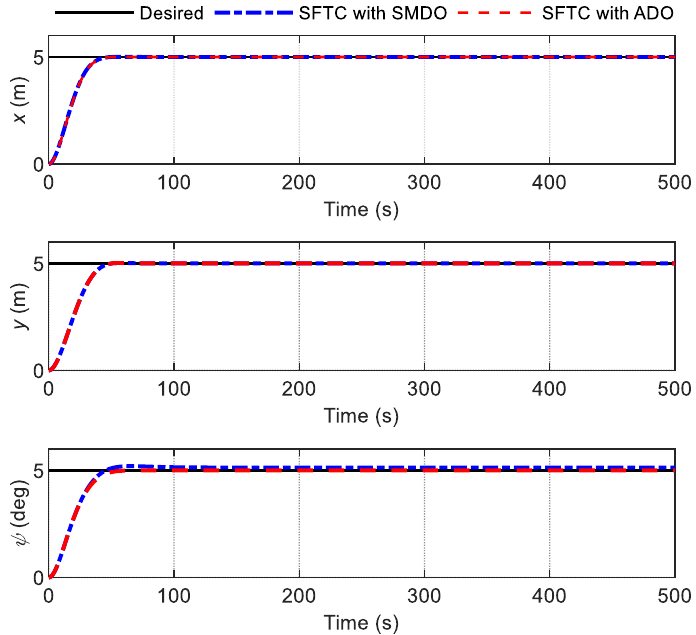
Figure 10. Position ( x , y ) and heading ψ (with environmental disturbances).